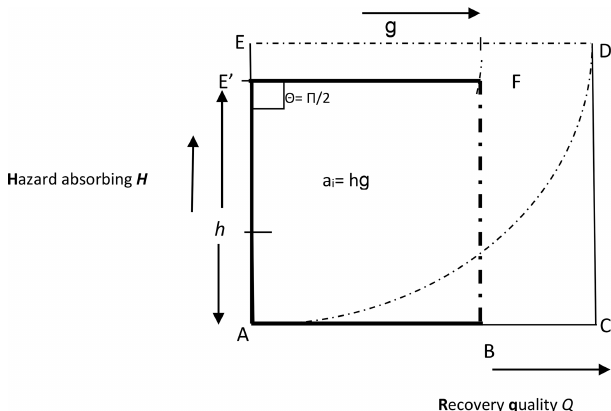
Figure 5. Resilience area ( a i = hg ). A variation of model Fig. 3 depicting an extreme case of a community with a perfect resource utilization system (efficiency of 1.0) which maximizes recovery re- sources’ g on absorbing capacity h